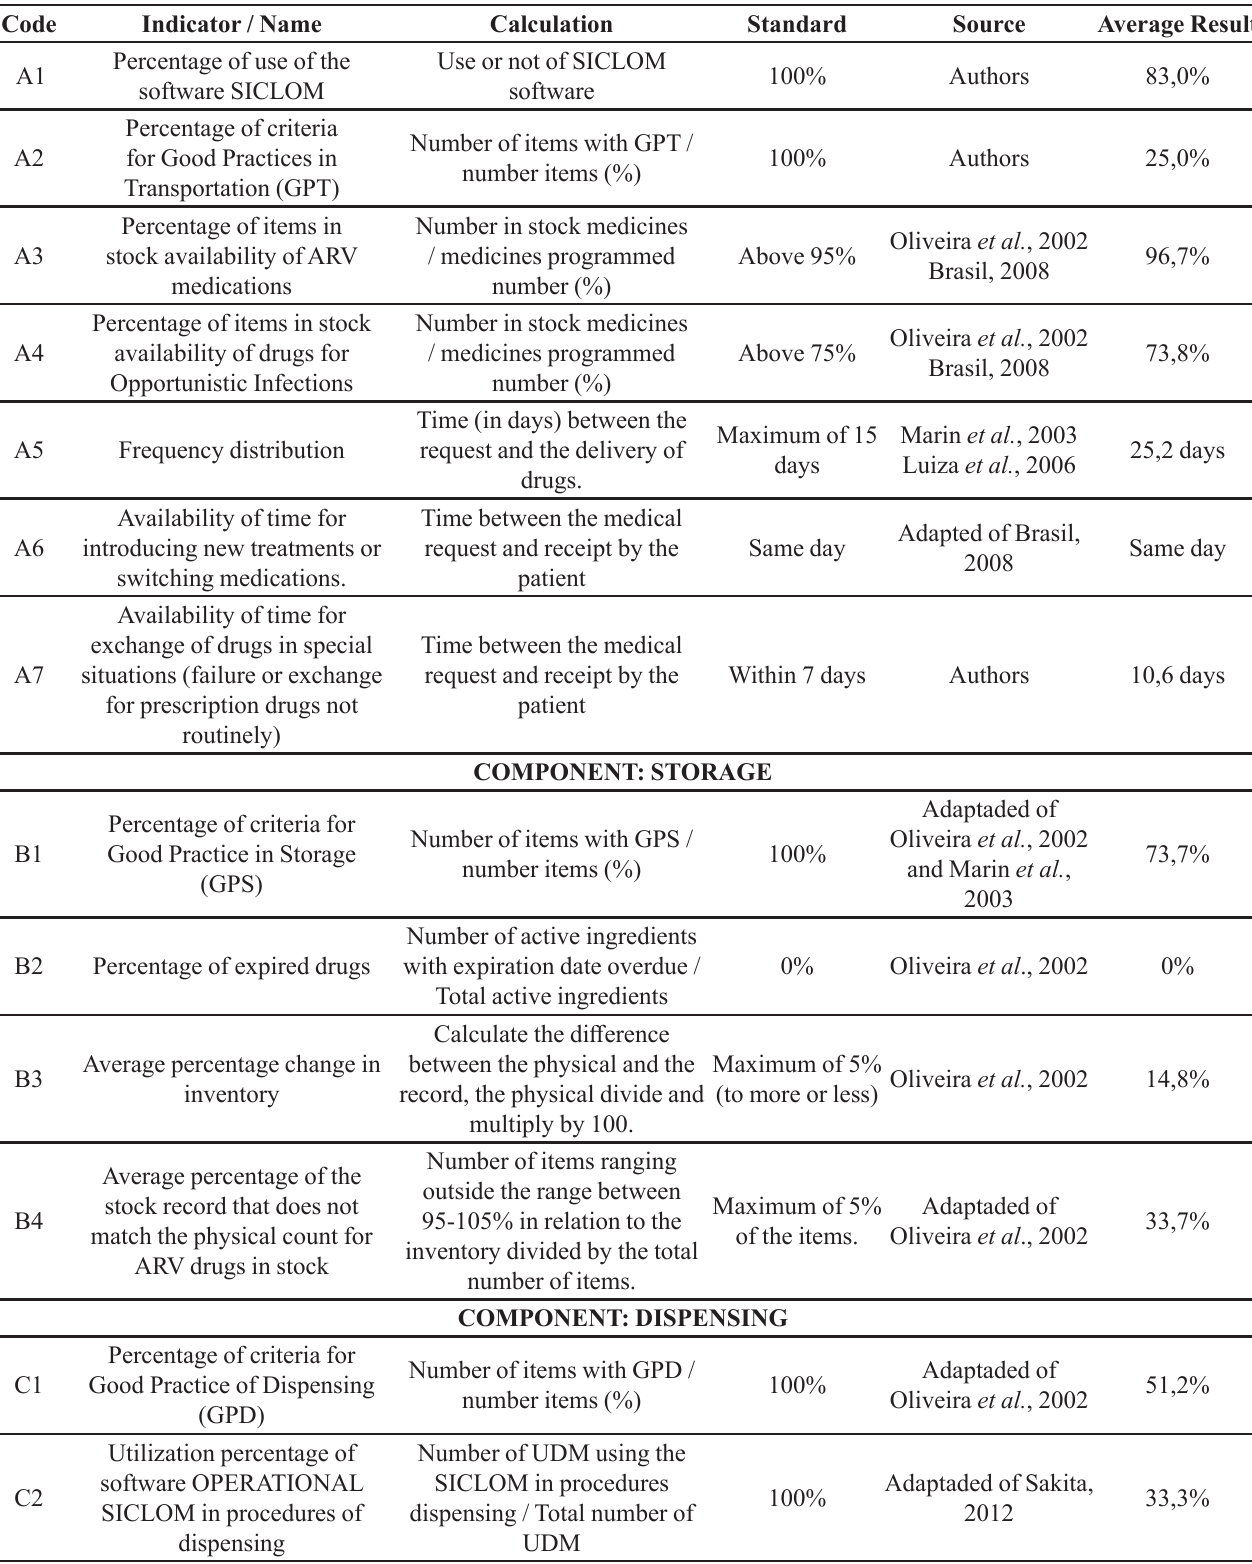
TABLE I - List of indicators used and results obtained (average results for UDM) COMPONENT: